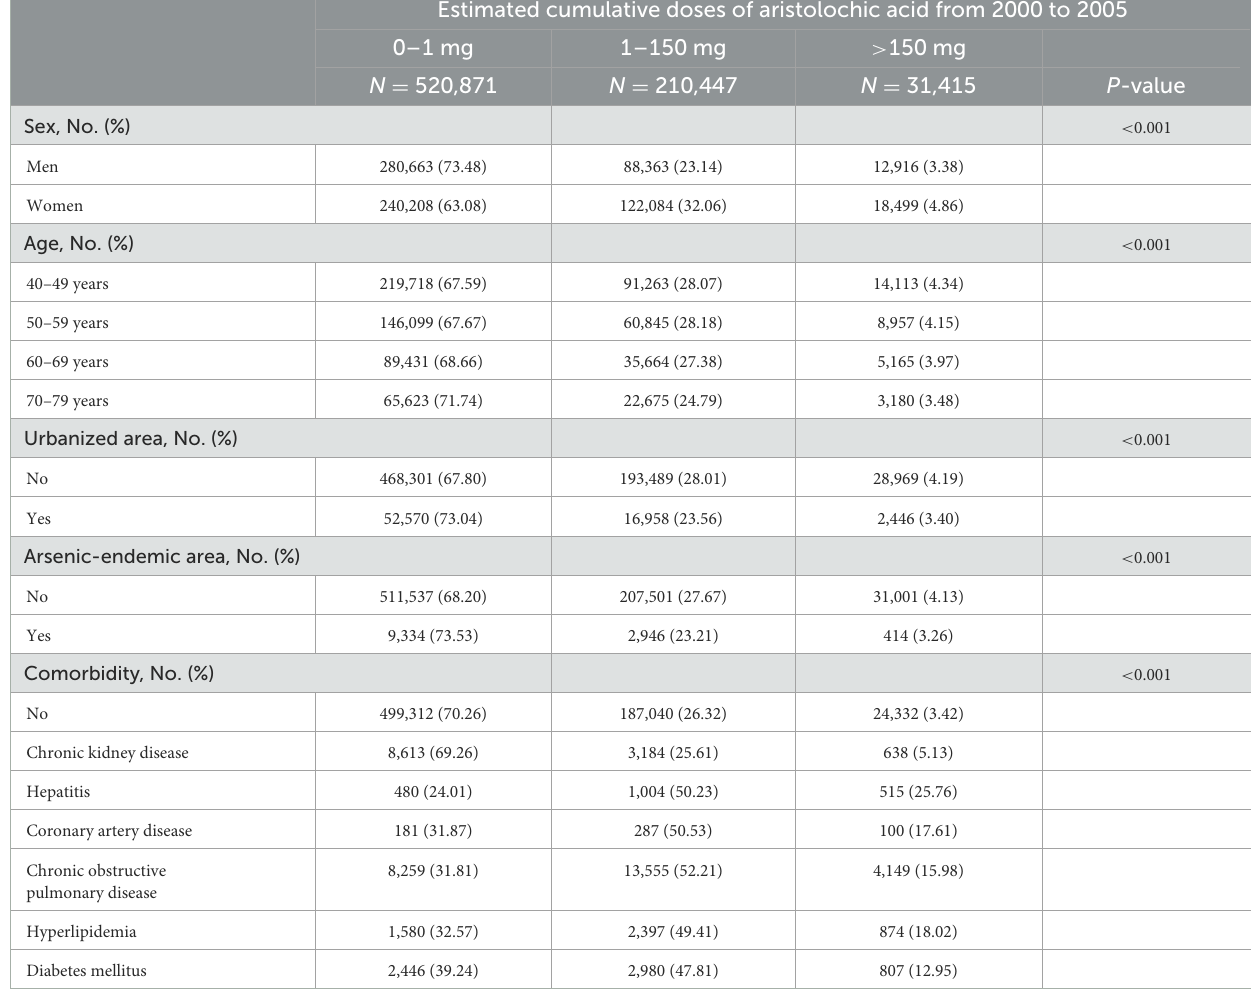
TABLE 1 Characteristics of study participants from the National Health Insurance Research Database registry between 2000 and 2005. Estimated cumulative doses of aristolochic acid from 2000 to